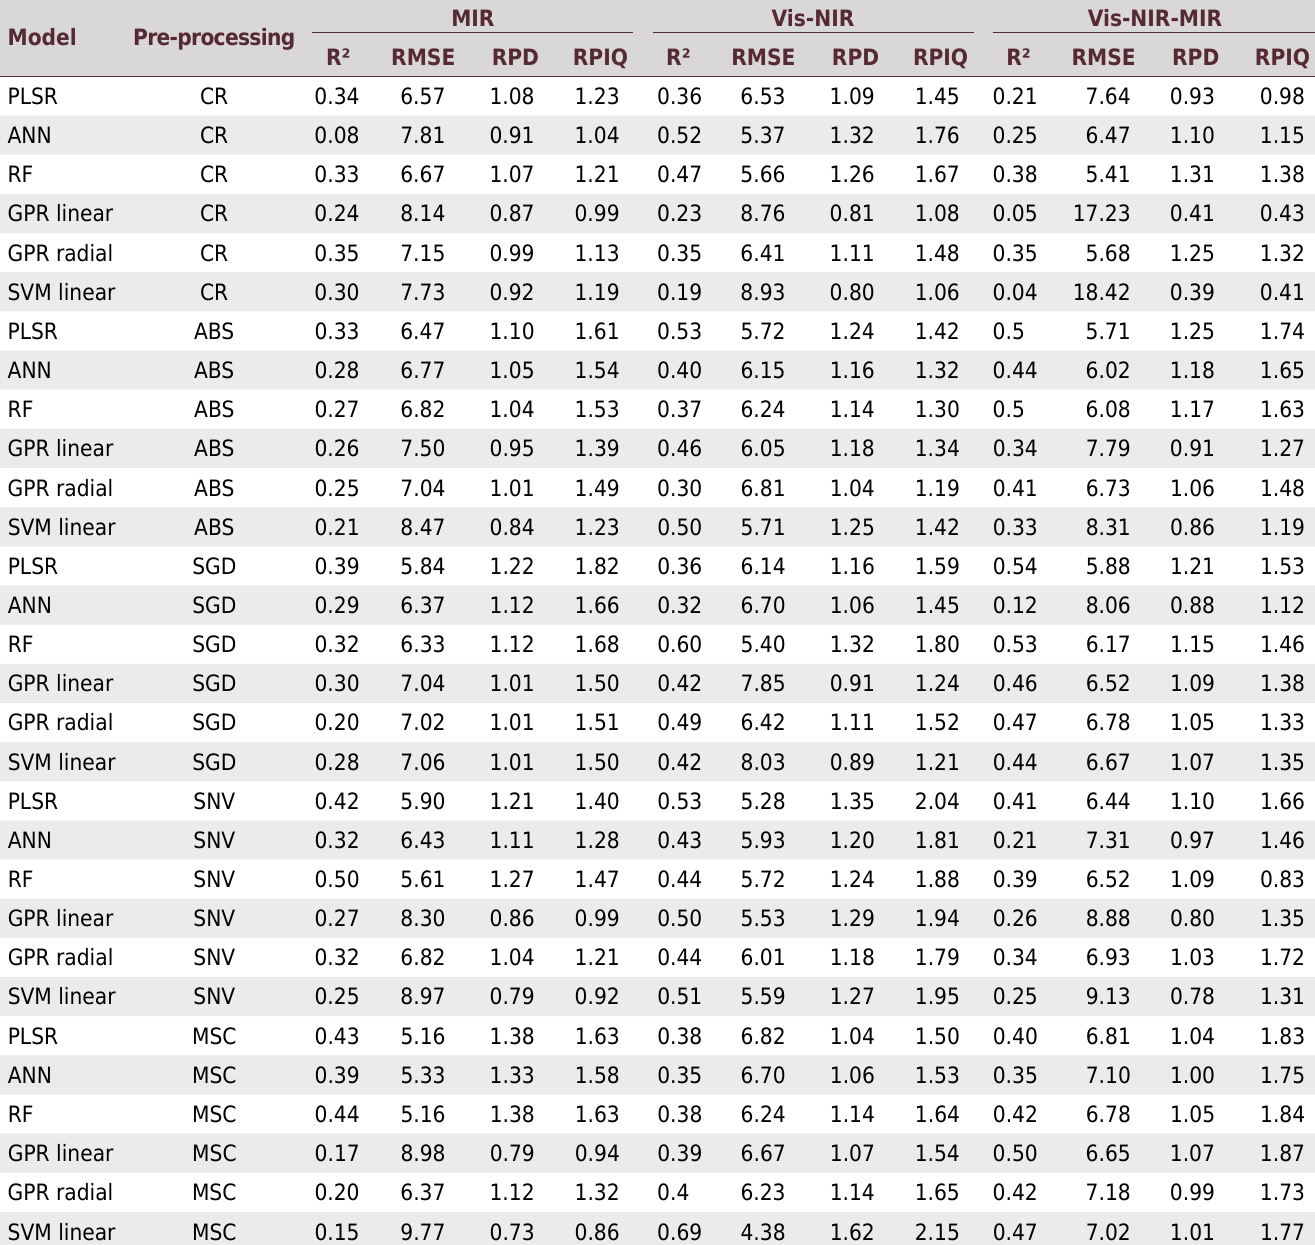
Table 2. Values of R 2 , RMSE, RPD (ratio of performance/prediction to deviation), and RPIQ (ratio of performance/prediction to interquartile range) for the clay property found for the different models and preprocessing methods in the MIR, Vis-NIR, and Vis-NIR- MIR spectra Model Pre-processing